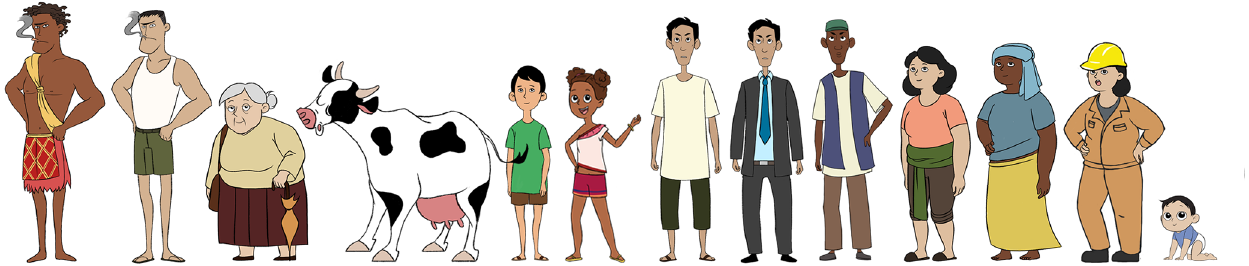
the regions surrounding major volcanoes on that